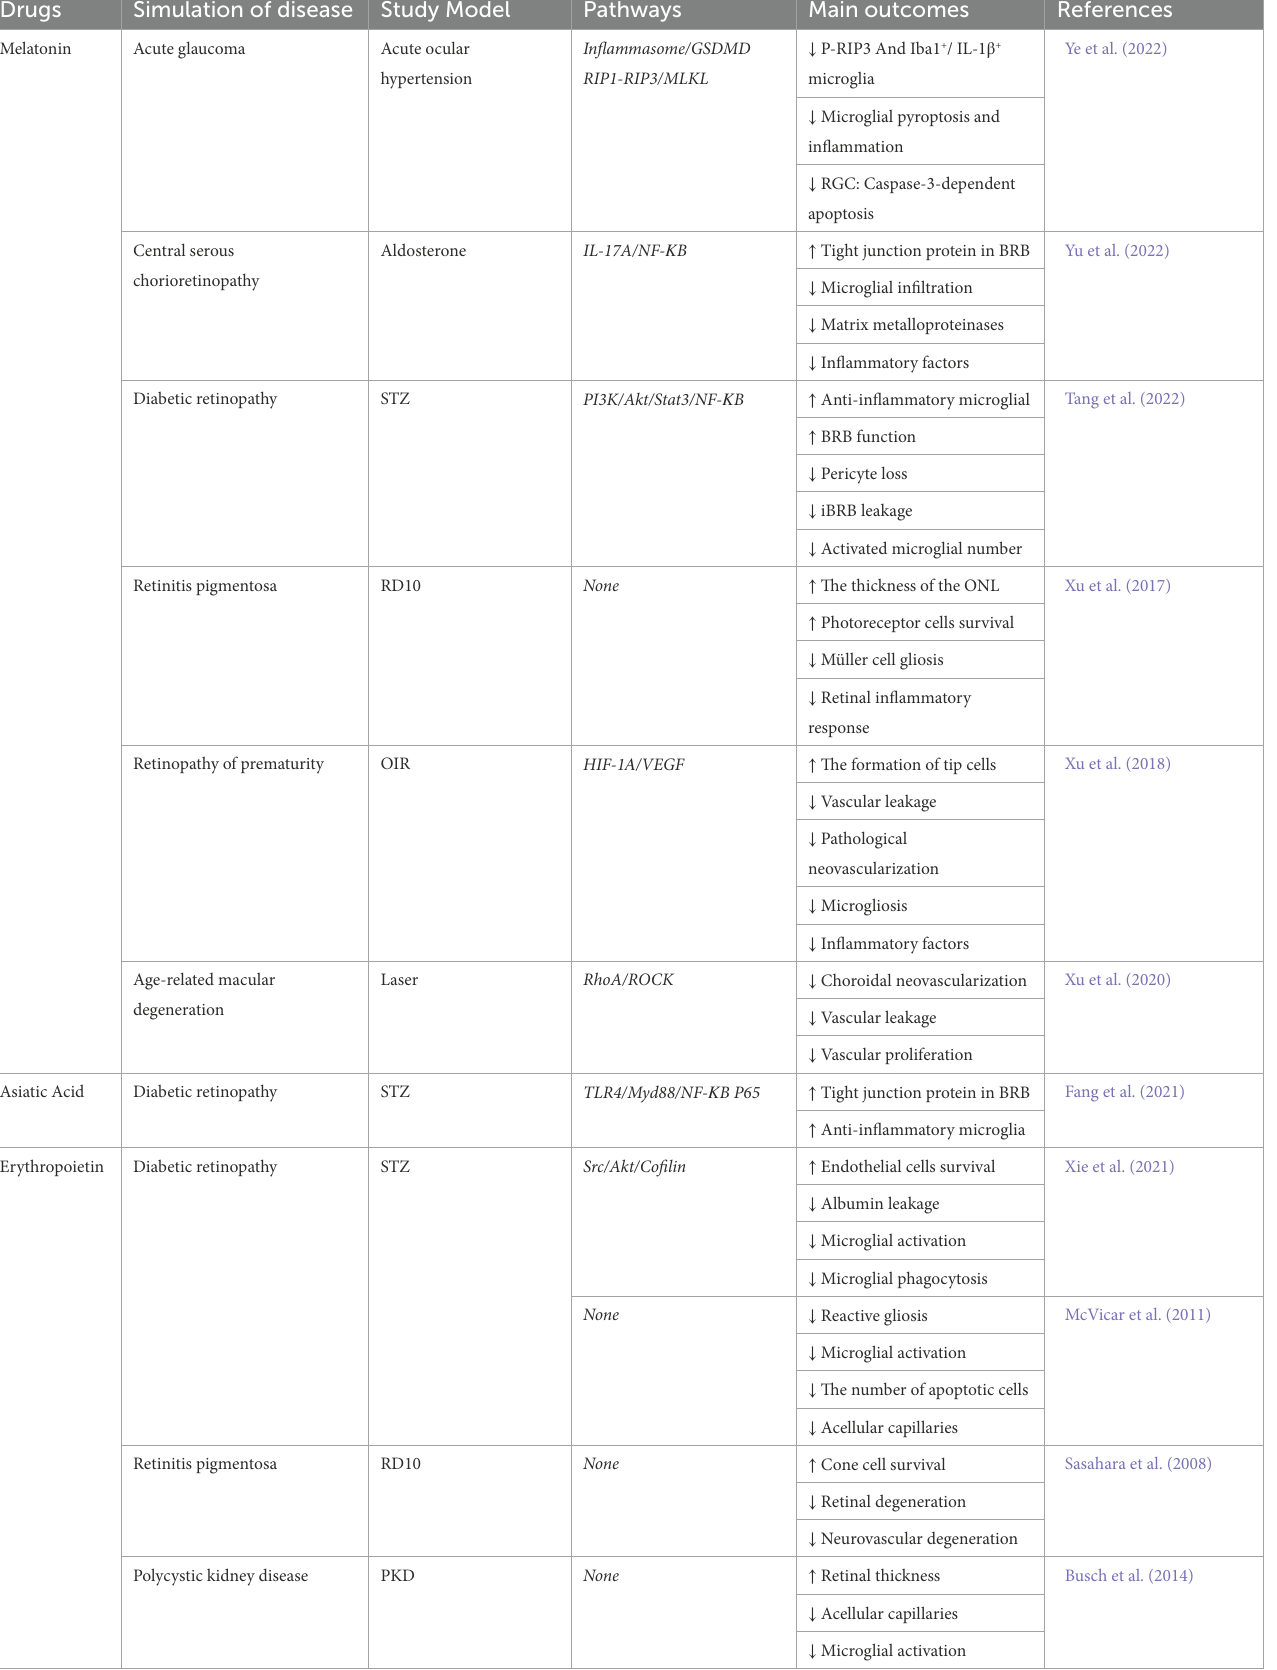
TABLE 1 Potential drugs treat the damaged BRB and the retinal neovascularization.